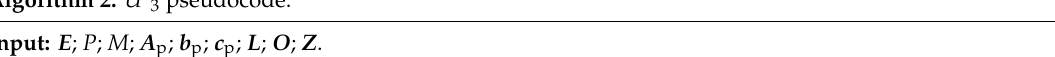
Algorithm 2. U * 3